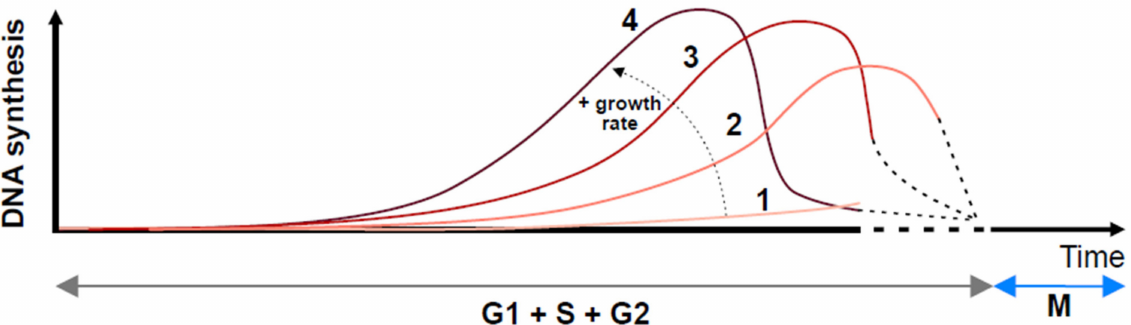
Figure 2. A continuum model of the cell cycle. In this model, the cells are not viewed as being at a point within, or outside, a cycle but in only one of two states, interphase (which is the sum of G1, S and G2 phases of the popular model) or mitosis. In interphase, DNA synthesis occurs at a rate that depends on the global biosynthetic capacity (growth rate). Four different rates are shown (1–4). DNA synthesis rates are not constant but increase exponentially as more replication origins are activated, and then decrease and are completed (dashed lines) prior to mitosis. In the popular model, the low DNA synthesis rates on either side of the peak, which are not detected macroscopically, correspond to G1 and G2. Curve 1 describes an extremely low biosynthetic rate; cells have not exited the cycle but synthesize DNA at such a slow rate that no macroscopic S-phase is experimentally seen. Curves 2–4 describe cells that appear, according to the popular model, to have variable G1 and G2 phase